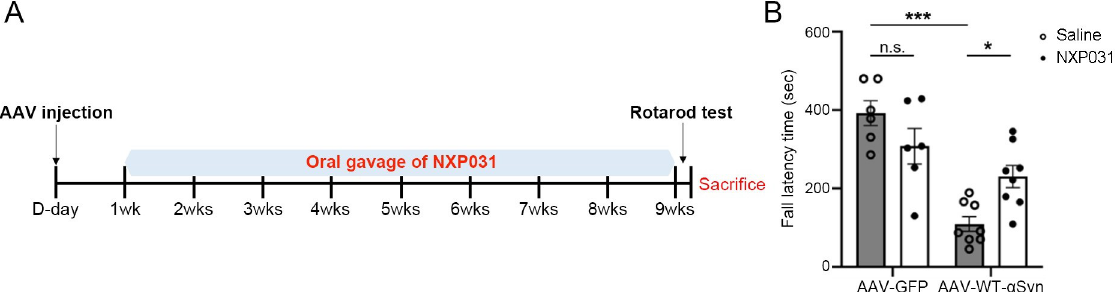
Fig 1. (A) Experimental paradigm. (B) Effect of NXP031 on the rotarod test at 9 weeks after delivery of GFP-only or α -Syn AAV in the SN. Latency to fall time (sec) in the rotarod test. Data are presented as the mean ± S.E.M. (Two-way ANOVA followed by Tukey’s test, � p < 0.05, ��� p < 0.001 compared to selected group, n = 6–8 mice per